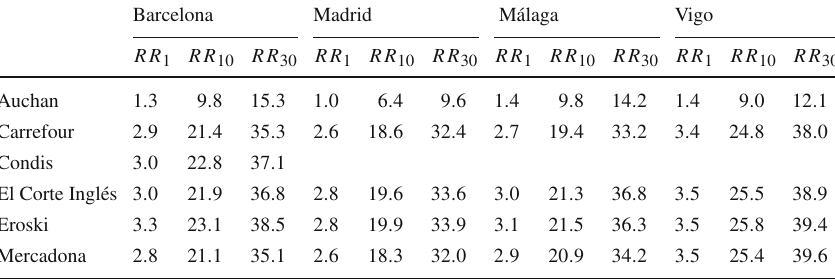
Table 2 Average change in price ranking at four locations Barcelona Madrid